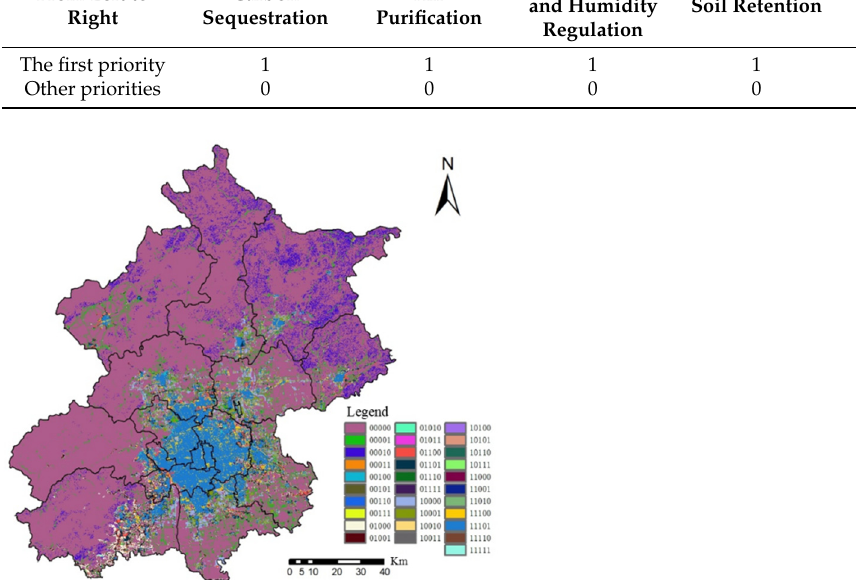
Figure 5. Pixel-scale distribution of priority areas for category-based ECC improvement. Table 2. Binary code table.